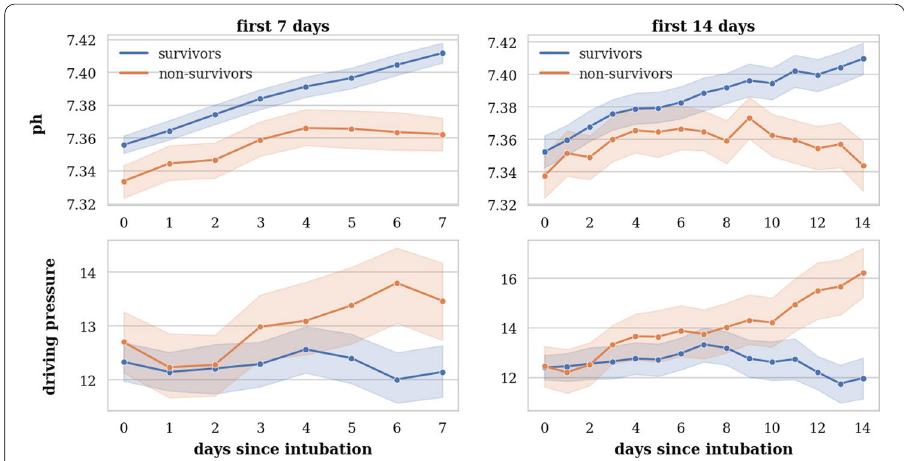
Fig. 3 Course of pH and driving pressure. Plots show the course of pH and driving pressure only for patients intubated at least 7 (left) or 14 (right) days,